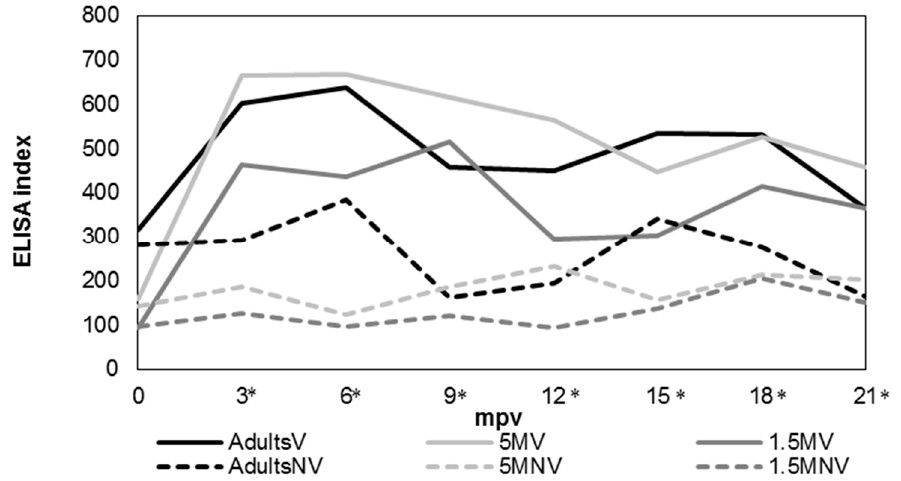
Figure 5. Evolution of antibodies production against MAP according to each experimental group.